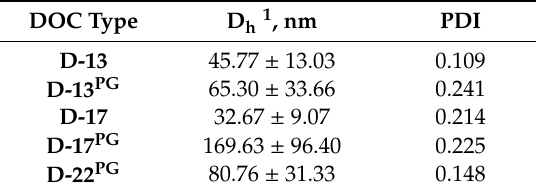
Table 1. The average hydrodynamic diameter (D h ) of the DOC micellar particles.